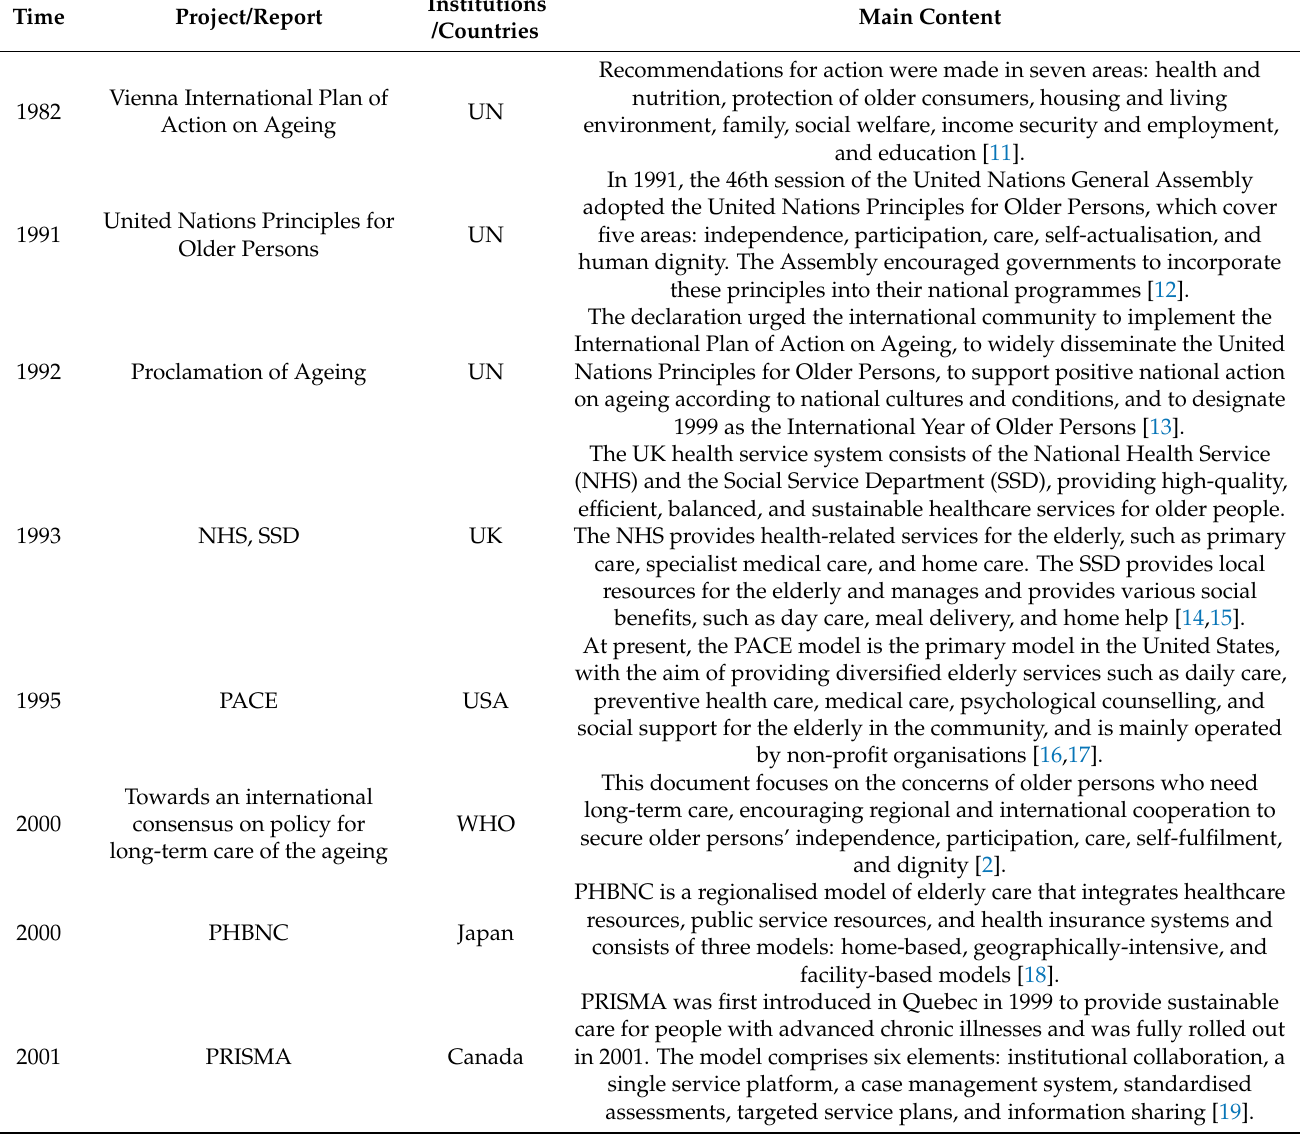
Table 1. FCMNCE research-related